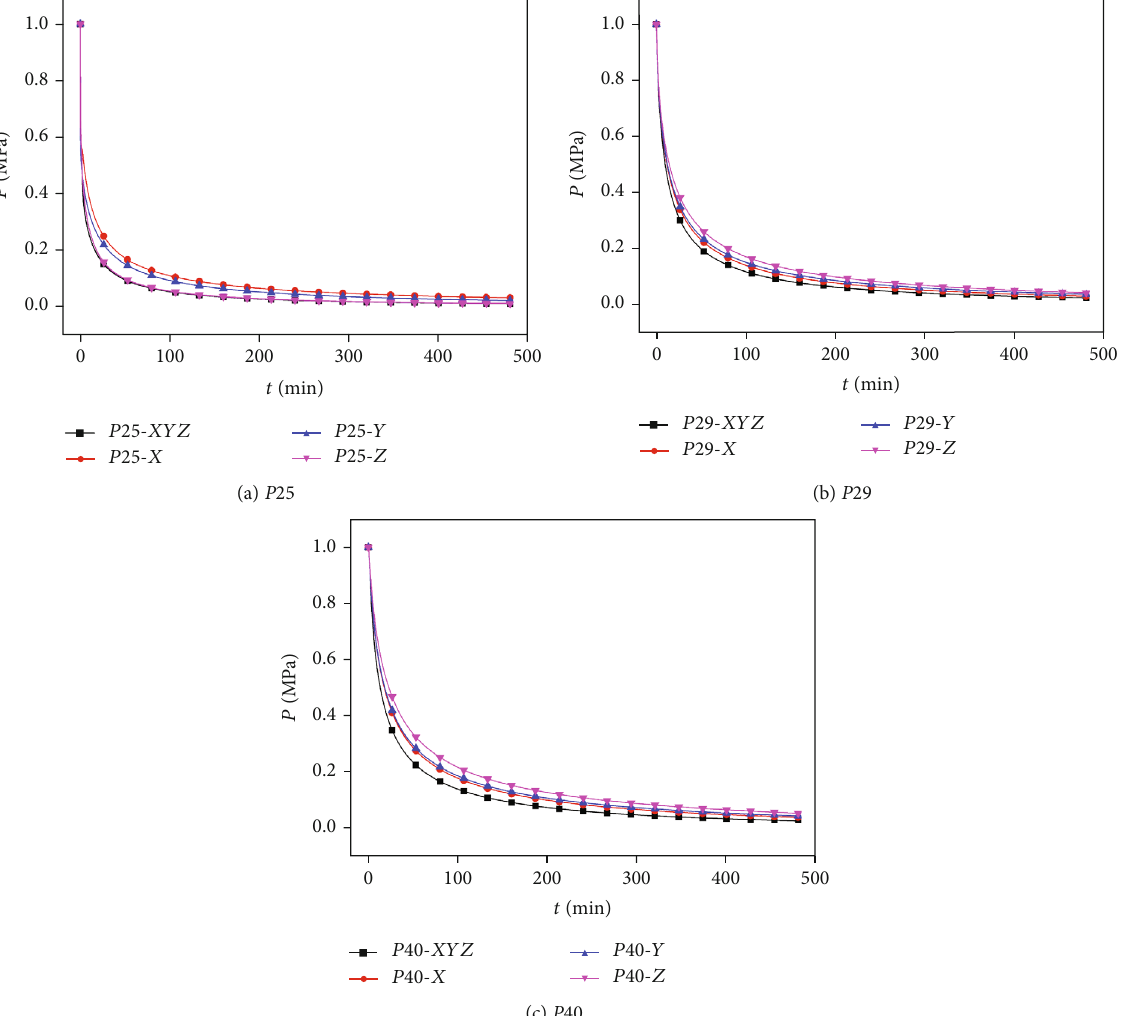
Figure 6: Evolution of gas pressure under di ff erent unloading stress